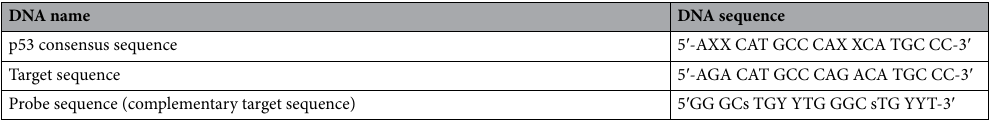
Table 1. DNA sequence for target DNA and probe DNA. S Abasic site, X A or G, Y C or T. To capture the p53-binding motif, we utilized the binding consensus sequence of TP53 (upper row), which was previously reported 21 . The target sequence is set to be 5 ′ -AGA CAT GCC CAG ACA TGC CC-3 ′ (middle row) in this study. Actually, the p53 recognition sites consist of two half-sites, which are separated by various length of sequences from 0 to 13 nucleotides. Since the spacer sequences vary; of 288 sequence samples, 236 (82%), 27 (9%) and 25 (9%) have 0, 1, and more spacers 23 , we utilized capture oligos with abasic-site spacers because they could cover significantly in total of p53 recognition sites based on the pervious study 23 . Therefore, to capture the target DNA, we designed the sequence (5 ′ -GG GCs TGY YTG GGC sTG YYT-3 ′ ) as this probe DNA, where s (abasic site), X (A or G), and Y (C or T) in the probe sequence are used to provide redundancy in probe selectivity. Importantly, the abasic site is potential target of thymine (T) and its fluorinated thymine (FTD: trifluridine) in order to avoid forming any hydrogen bonds with T or FTD. As the abasic site, we utilized tetrahydrofuran-type abasic sites (1 ′ ,2 ′ -dideoxyribose), which is called as “dSpacer”, for the spacer of capture sequence.